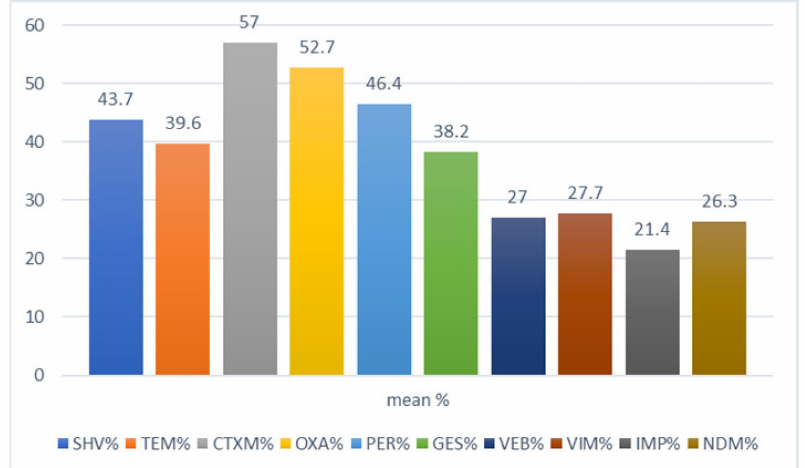
Figure 6. Distribution of β -lactamase genes among E. coli and ESKAPE pathogens in the Arab